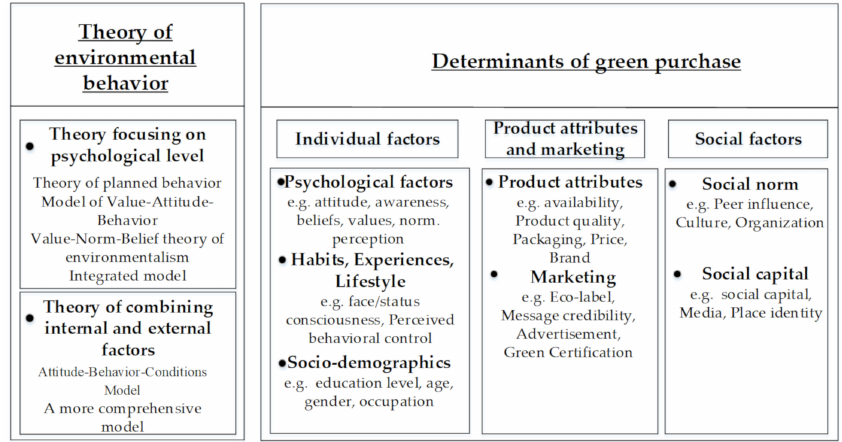
Figure 1. Framework of material